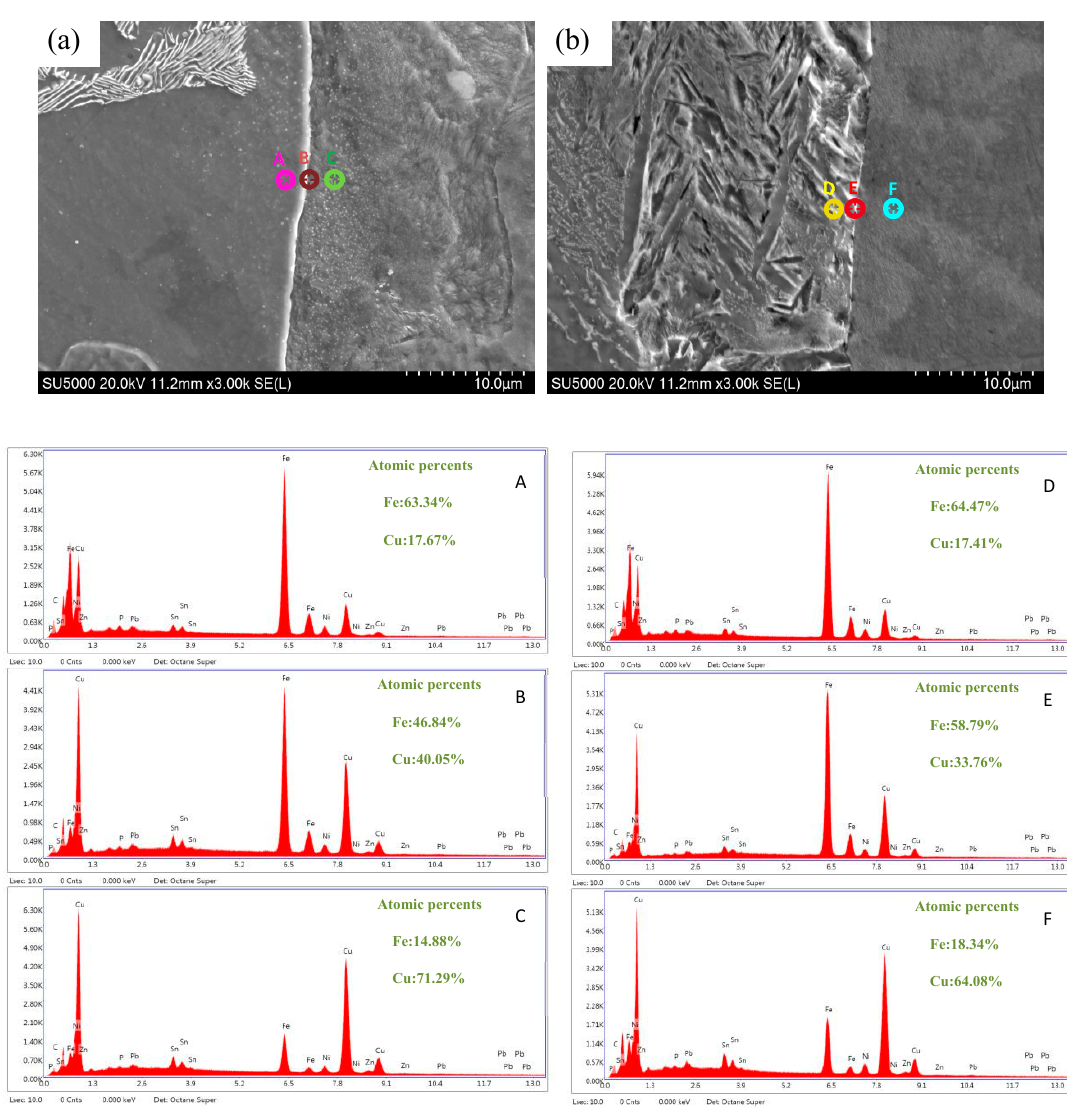
Figure 7. SEM micrograph and EDS analysis of the steel / copper bimetallic interface: ( a ) pearlite / copper interface and ( b ) ferrite / copper interface.